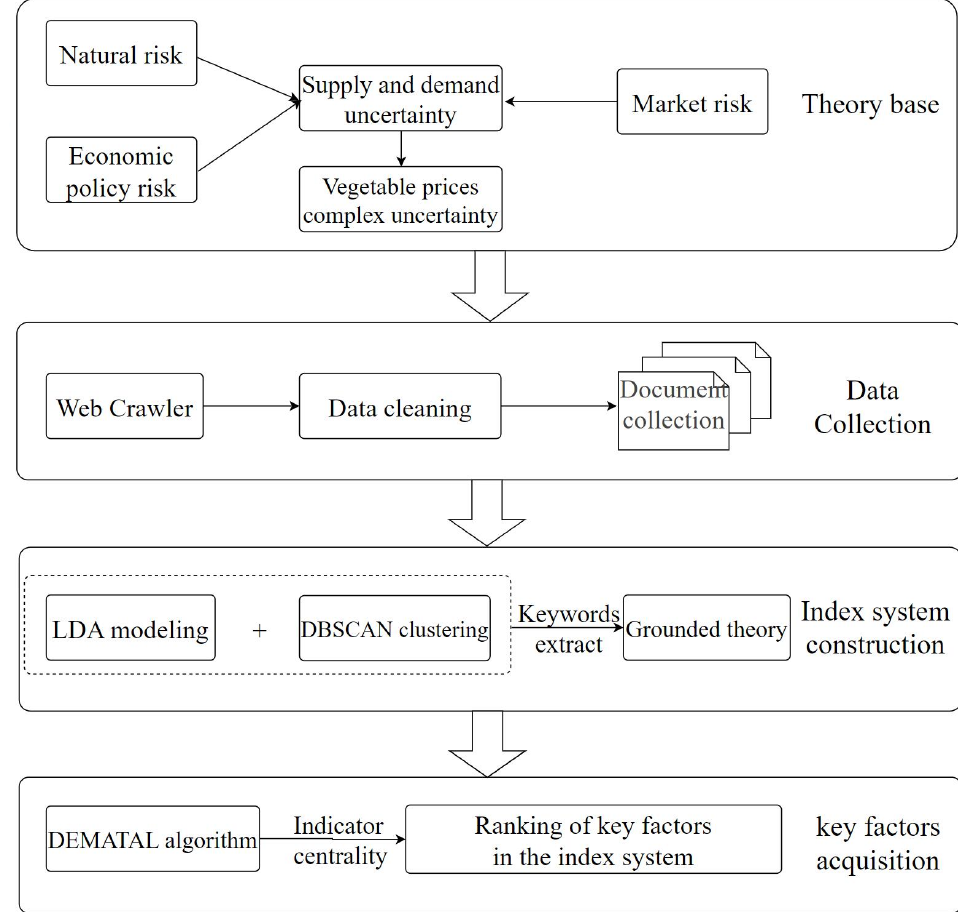
Figure 1. Theoretical model